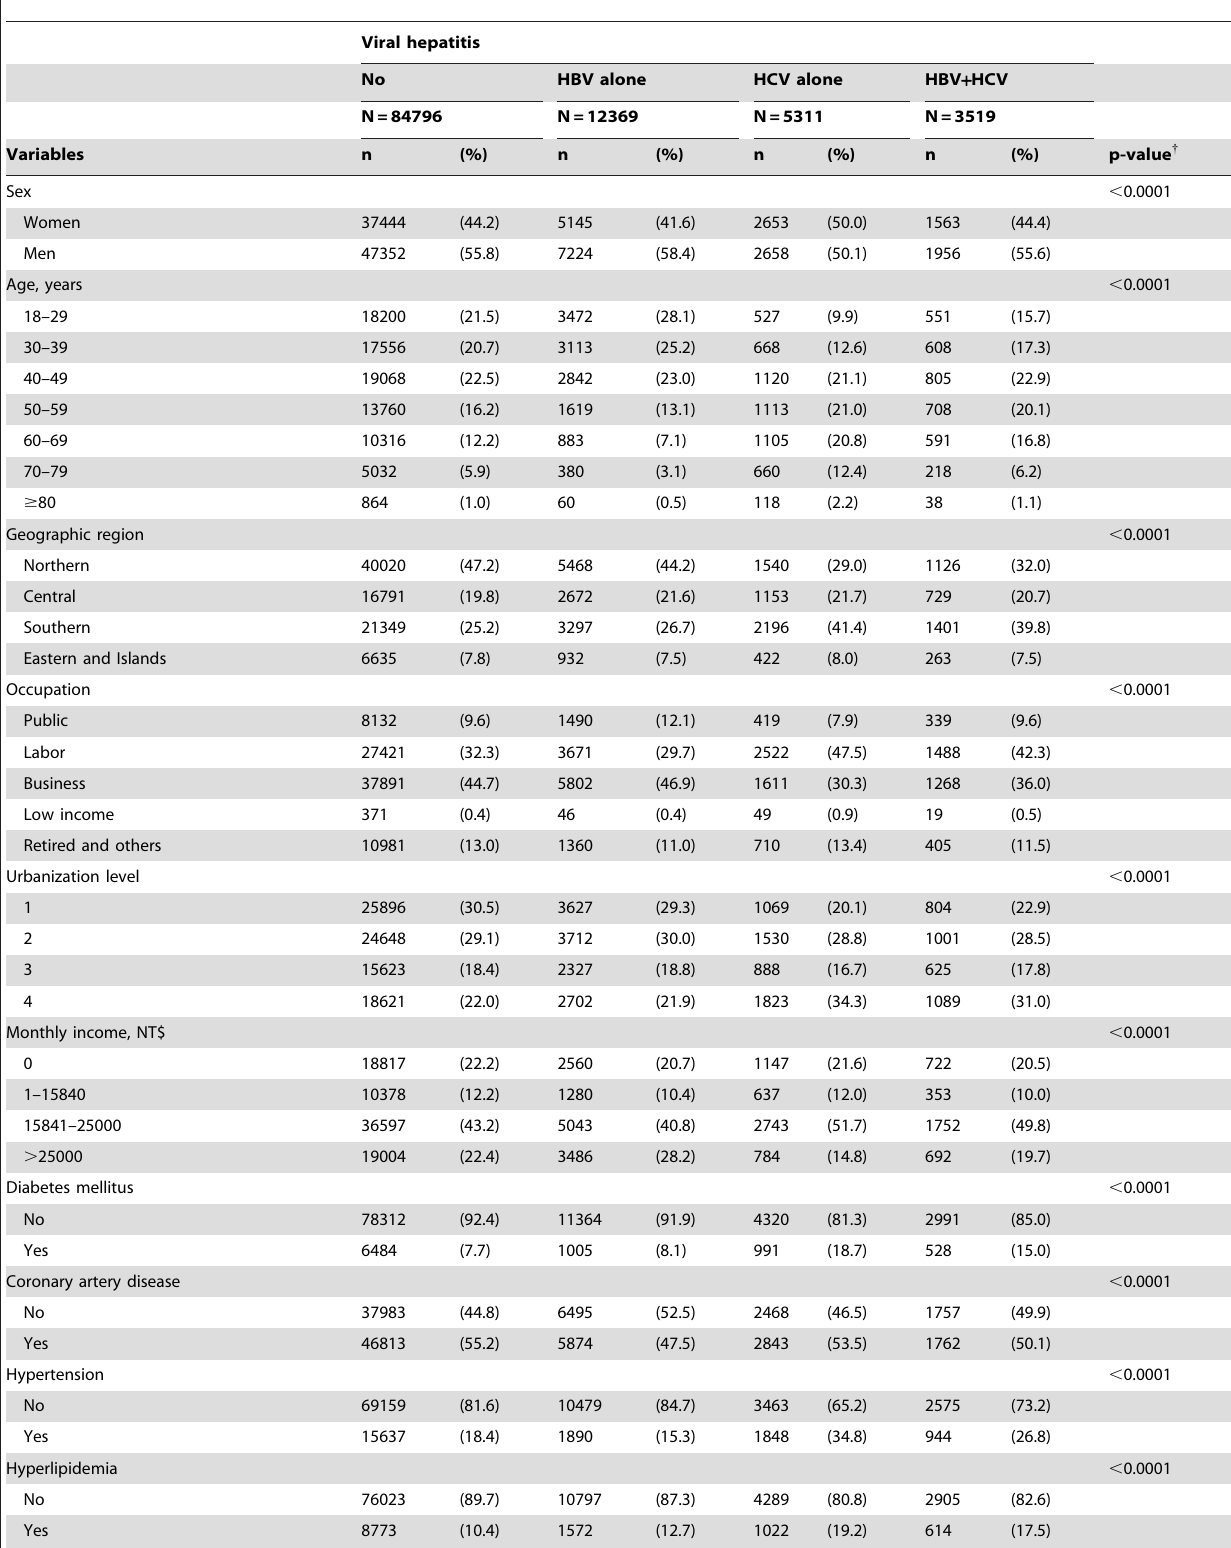
Table 1. Baseline characteristics and comorbidities between viral hepatitis and non-viral hepatitis adult groups identified in 2000–